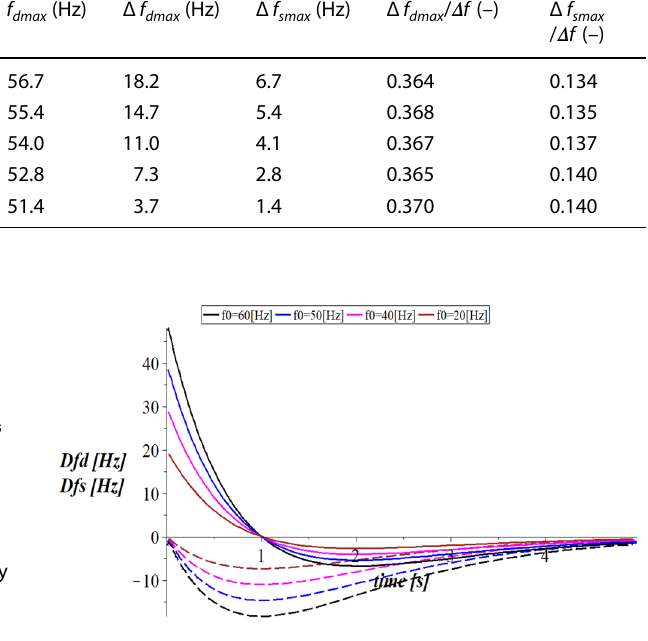
Fig. 15 Overshoot of frequency f c 3 ( t ) of current, for exponen- tial decrease ( T = 0.075 (s) ) of voltage frequency f v 3 ( t ) , from